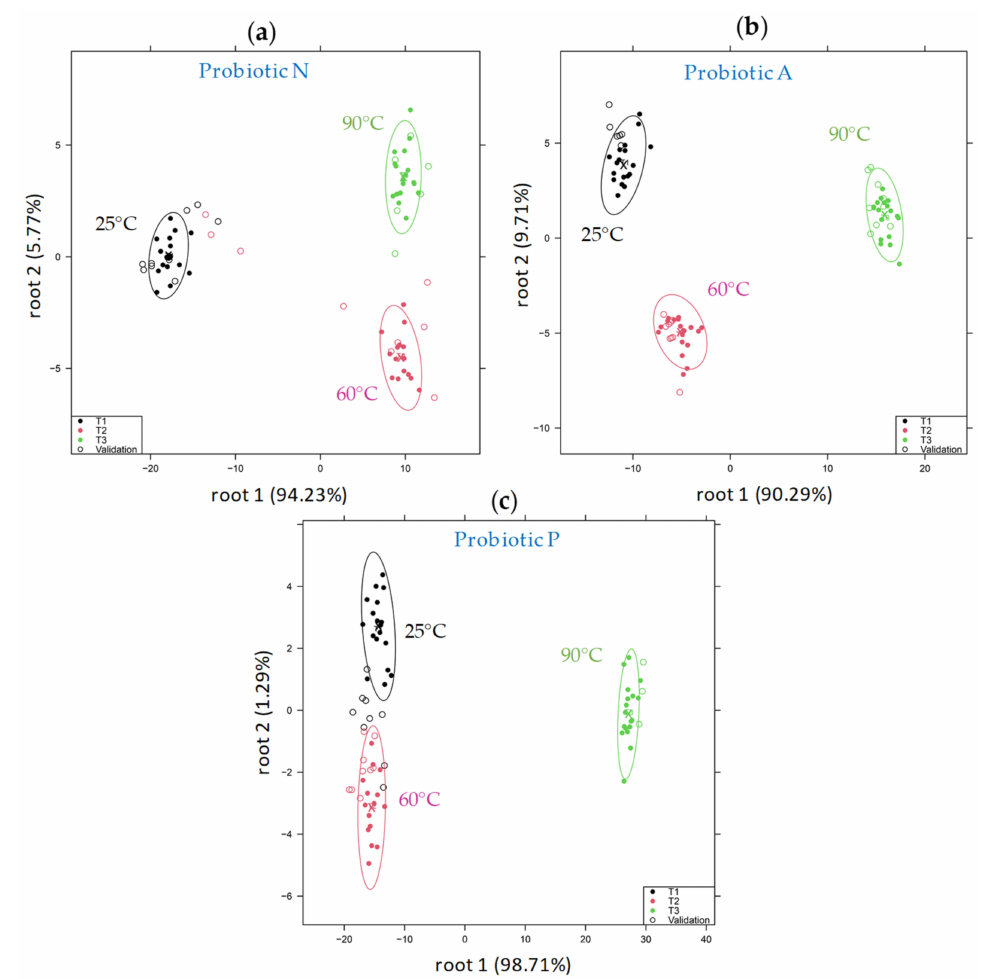
Figure 5. PCA-LDA for probiotic samples from concentration (C1) according to the temperature level for each probiotic type ( a ) probiotic N, ( b ) probiotic A, and ( c ) probiotic P. Built with 95% confidence interval ellipsis. The center of the ellipses is denoted by x, training and validation sets are denoted by solid and hollow points, respectively. N = 75 for probiotic N, N = 78 for probiotic A, and N = 72 for probiotic